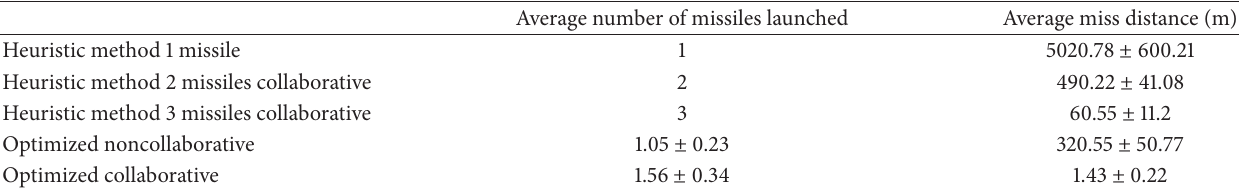
Table 1: Average number of missiles and average miss distance obtained by different methods, averaged over 100 random initial conditions of the ballistic